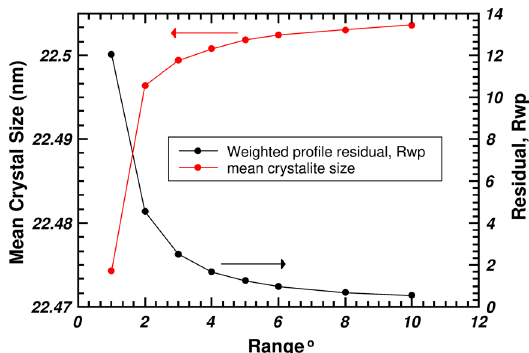
Figure 6. Mean crystallite size and weighted profile residual error as a function of fitting range angle around a peak for the smallest chord length, 1.25 nm